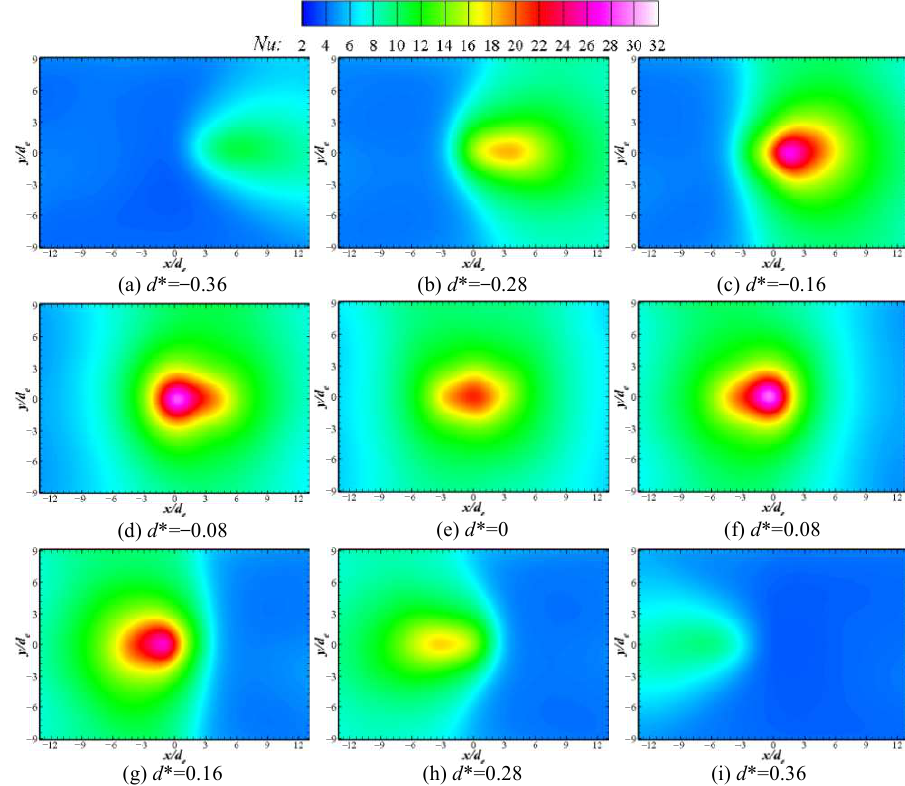
Figure 3. Nu contours on the impingement surface at different slider locations. Figure 4a draws the Nu on the centerline y / d e = 0 along the x -axis. The solid dot represents the peak Nu on the curves. It can be seen that the curves at the same | d *| are symmetrical with the line x / d e = 0. With the increase in | d *|, the curves and peak point of Nu gradually move away from the center, which is consistent with the variation trend of the vectoring angle (shown in Figure 2). The peak Nu reaches its maximum at | d *| = 0.08 rather than at the center location. The reason is that the DSJ velocity increases with the increase in | d *|, which improves the local cooling performance. As | d *| continues to in- crease, the thickness of the viscous layer in the slot neck gradually grows and eventually fills the entire neck. As a result, the choking effect occurs in the slot neck and the DSJ velocity reduces. Moreover, the vectoring angle increases with the increase in | d *| (shown in Figure 2) and the impingement DSJ will gradually transform to a cross flow, resulting in the weakness of the cooling performance. There are three local peaks of Nu avg at d * = 0 and ±0.28 (shown in Figure 4b). The reason is that at the beginning of | d *| increase, the DSJ velocity increases, which improves the whole cooling performance. As | d *| continues to increase, the choking effect impairs the DSJ velocity, and meanwhile the increase in vectoring angle enhances the cross-flow effect of the DSJ. Thus, the whole cooling perfor- mance reduces rapidly. Although the maximum values of Nu at d * = ±0.08 and ±0.16 are larger than that at d * = 0 (shown in Figure 4a), the values of Nu avg are smaller (shown in Figure 4b). Since the DSJ velocity d * = ±0.08 and ±0.16 are higher than that at d * = 0 owing to the smaller cross sections, and the local cooling performance. However, the vectoring angles at d * = ±0.08 and ±0.16 enhance the cross-flow effect and reduce the impingement stagnation region of the DSJ, which causes the decrease in overall cooling performance.